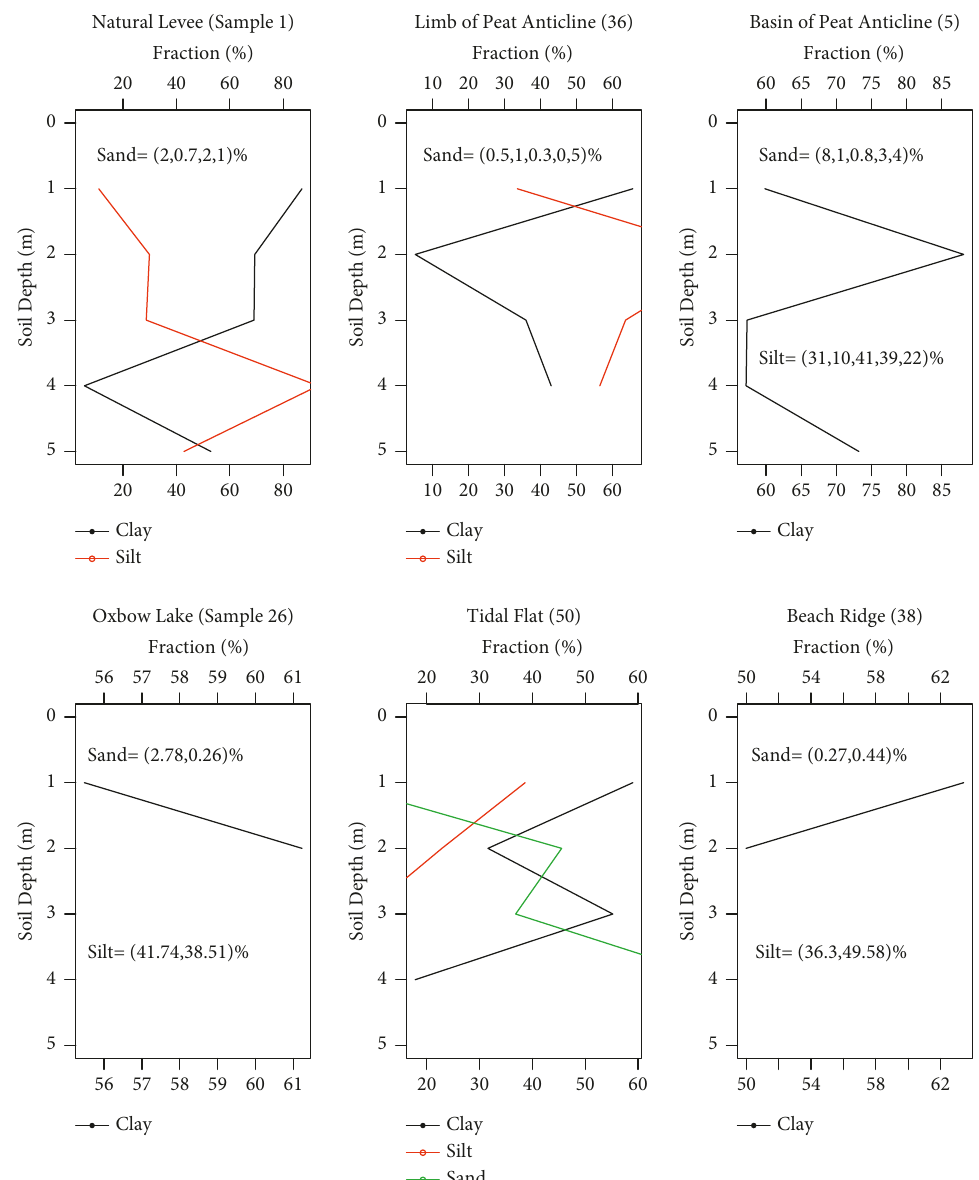
Figure 4: The percentage of soil fraction vs soil depth in various landforms of Barito Delta. The low content of certain soil particle fraction, that is, sand fraction, is mostly not able to shown to all graphics in this figure because the percentage value is too low compared to other fractions so that its value is written in the text in each graphic of figure. For example, sand in 1 st depth is ∼ 2, 2 nd depth is ∼ 0.2, 3 rd depth is ∼ 4, and 4 th depth is ∼